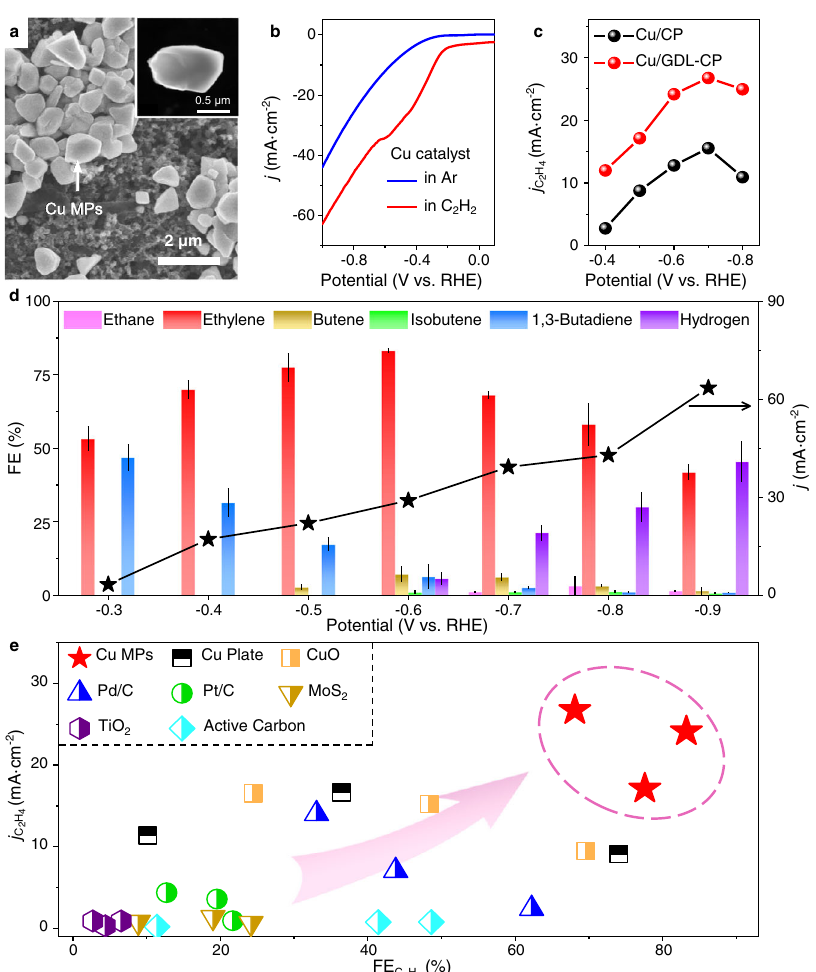
Fig. 2 Characterizations of the structure and E-HAE performance of the Cu catalyst. a SEM and HAADF-STEM (inset) image of the catalyst. b Linear sweep voltammetric curves in Ar-saturated and C 2 H 2 -saturated solution. The scanning rate is 10 mV s − 1 . c Comparison in the geometric current density of ethylene ( j C ) over the Cu microparticles (MPs) loaded on pristine carbon papers (Cu/CP) and carbon papers coated with the microporous gas 2 H 4 diffusion layer (Cu/GDL-CP). d FEs of the E-HAE products and the current densities at different potentials. Error bars correspond to the standard deviation. e Comparison in the FE and the geometric current density for ethylene production from E-HAE over different catalysts, which were tested in this work. All experiments were conducted in 1 M KOH solution at 25 °C. Source data are provided as a Source Data fi